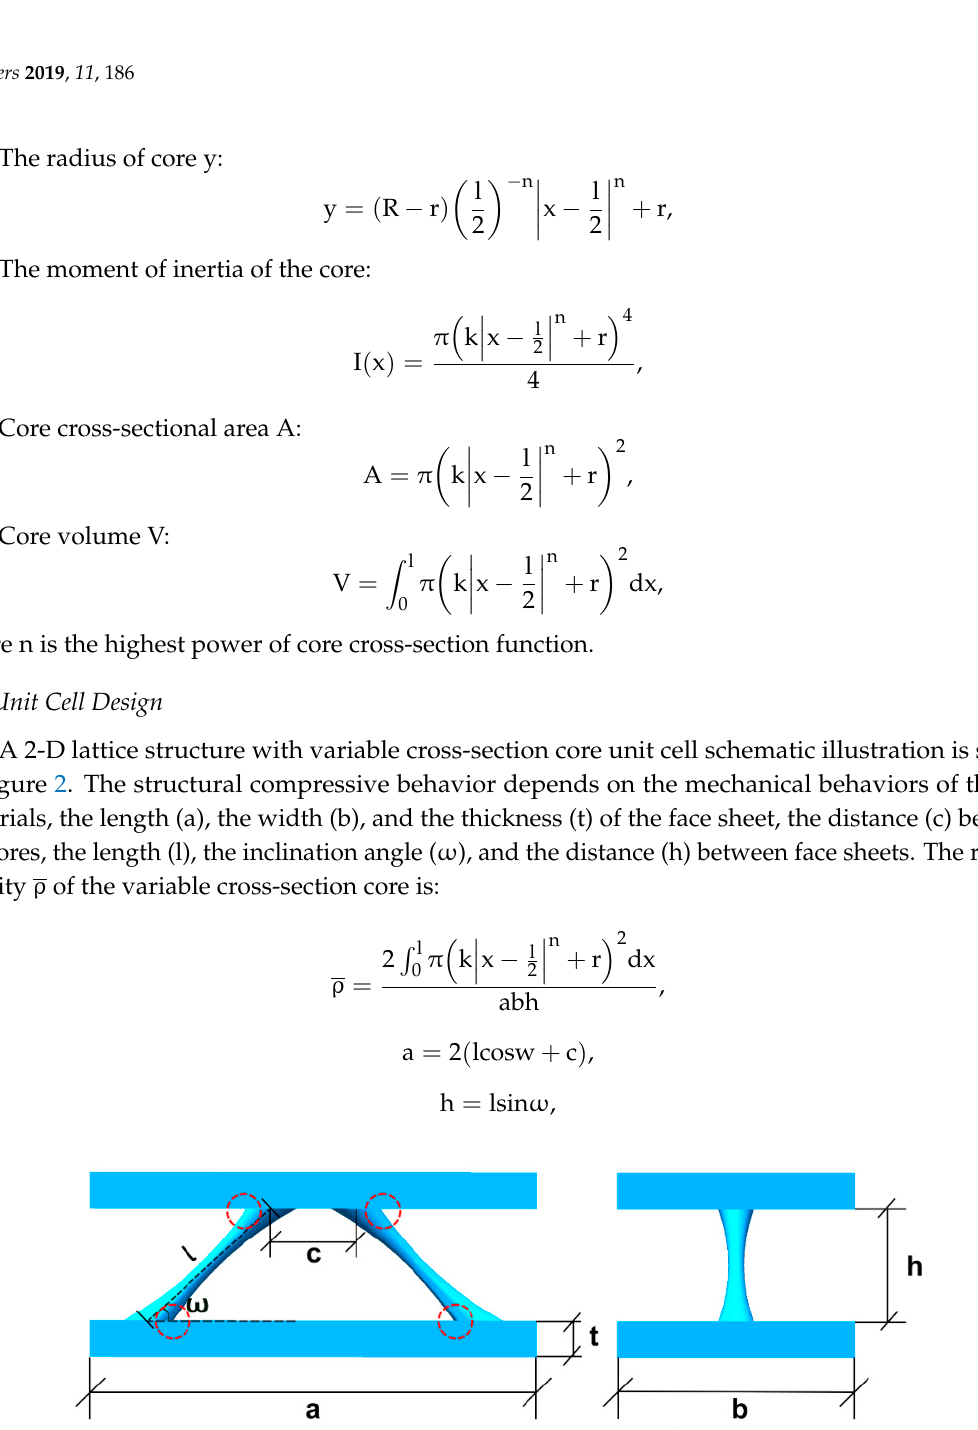
Table 1. Core cross-section functions.